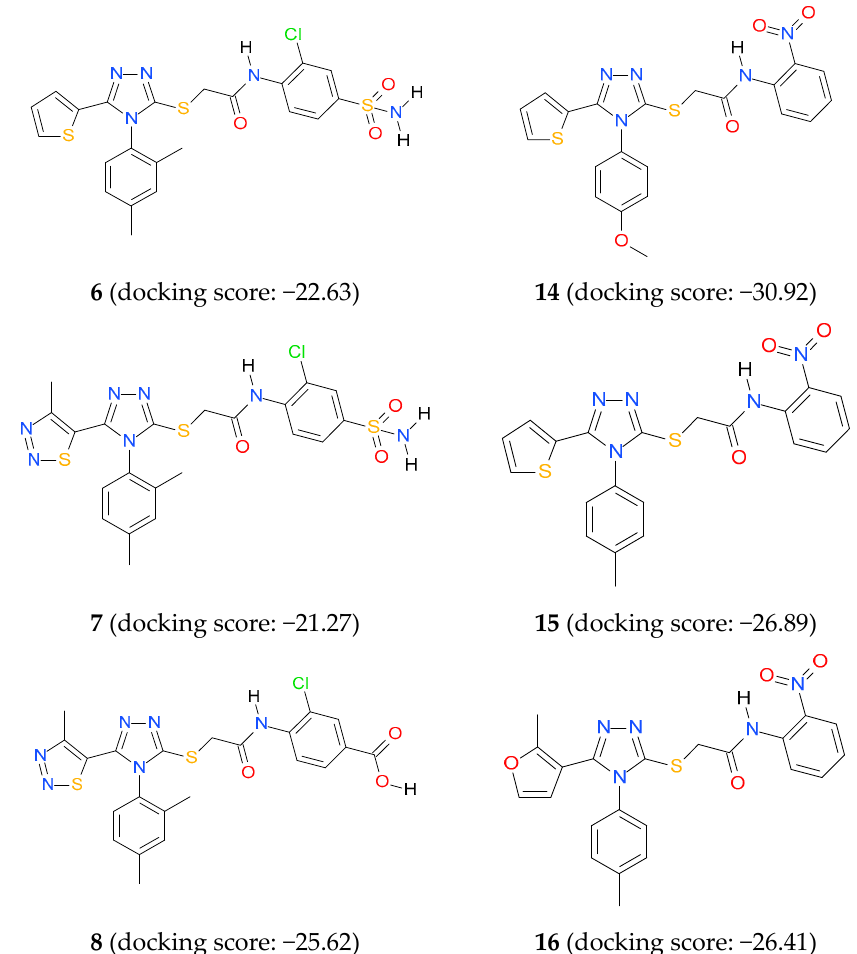
Figure 2. Docking scores for previously reported triazole NNRTIs ( 1 – 11 ) [6], known bacterial RNA polymerase inhibitor ( 12 ) [14], and designed triazoles with the N -(2-nitrophenyl)acetamide core ( 13 – 16 ) within bacterial RNAP “switch region”.